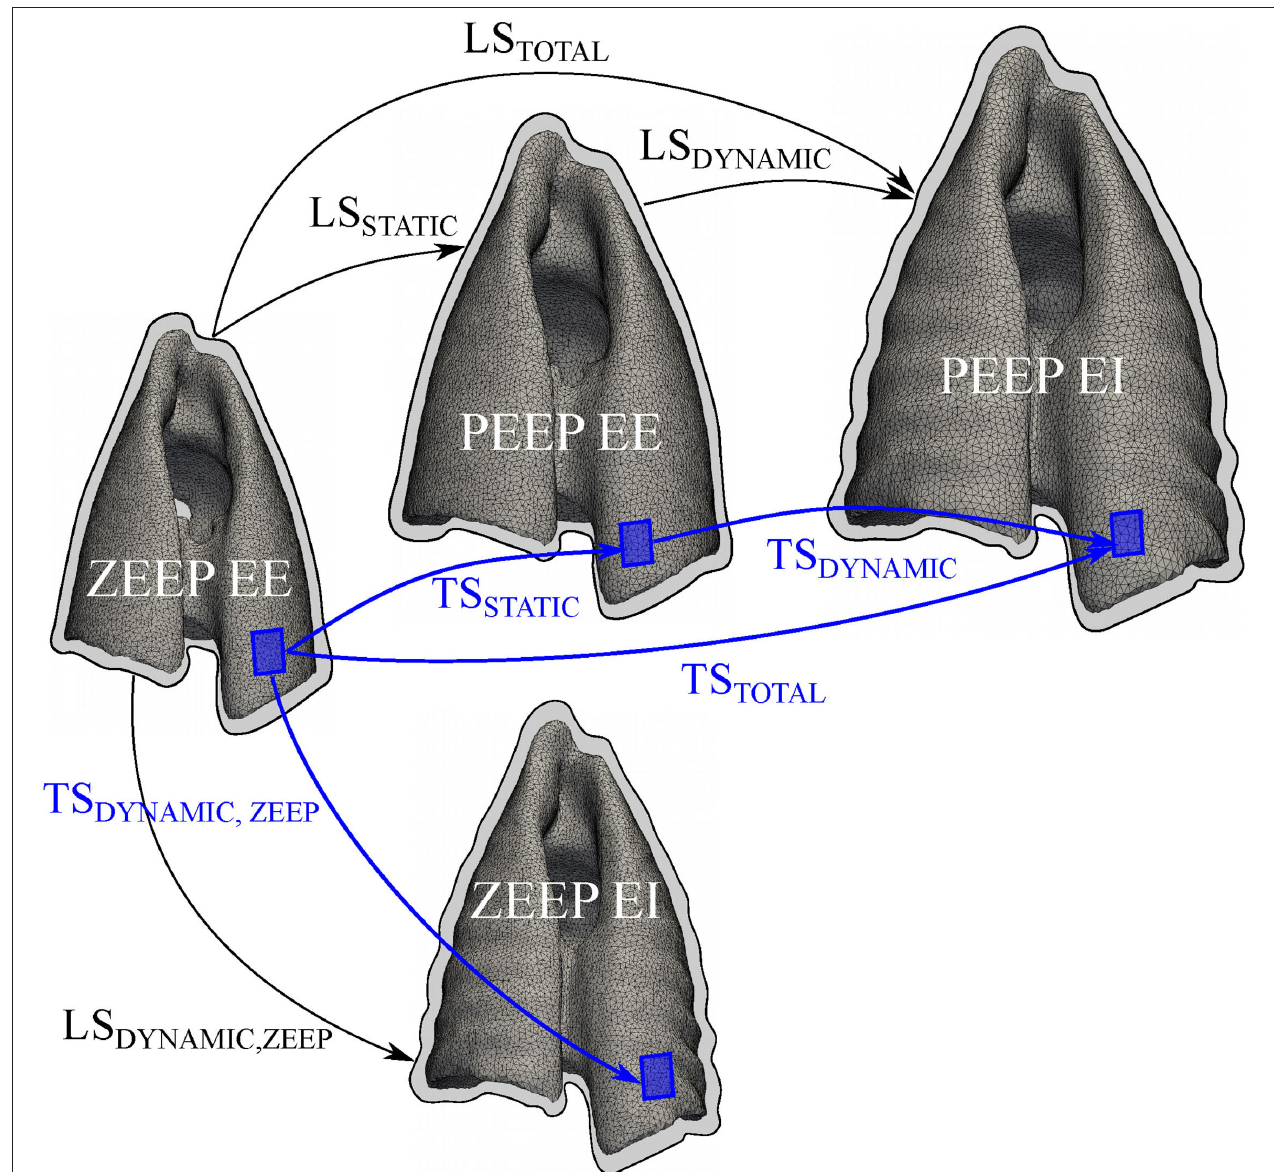
FIGURE 1 | Schematic of the deformation components of the lung and lung tissue. The lung strain (LS) and regional lung tissue (TS) strain were assessed in terms of static, dynamic, and total strain components. For the estimation of LS components, thoracic CT images were segmented to compute end-expiratory (EE) and end-inspiratory (EI) lung volumes (outlined with a black contour) during zero-end expiratory pressure (ZEEP) and positive end-expiratory pressure (PEEP). During PEEP, global static (LS STATIC ) and dynamic (LS DYNAMIC ) strains were calculated. The sum of LS STATIC and LS DYNAMIC rendered the total lung strain (LS TOTAL ). During ZEEP, static lung strain was assumed to be zero, and total lung strain was determined from the dynamic lung strain (LS DYNAMIC,ZEEP ) alone. For regional TS calculations (shown as blue boxes), a finite-element reconstruction method was used to generate 3D maps of lung tissue strain. Similar to the global analysis, regional static (TS STATIC ) and dynamic (TS DYNAMIC ) lung tissue strains were calculated, and summed to obtain a total (TS TOTAL ) strain. During ZEEP, only a dynamic (TS DYNAMIC,ZEEP ) strain was